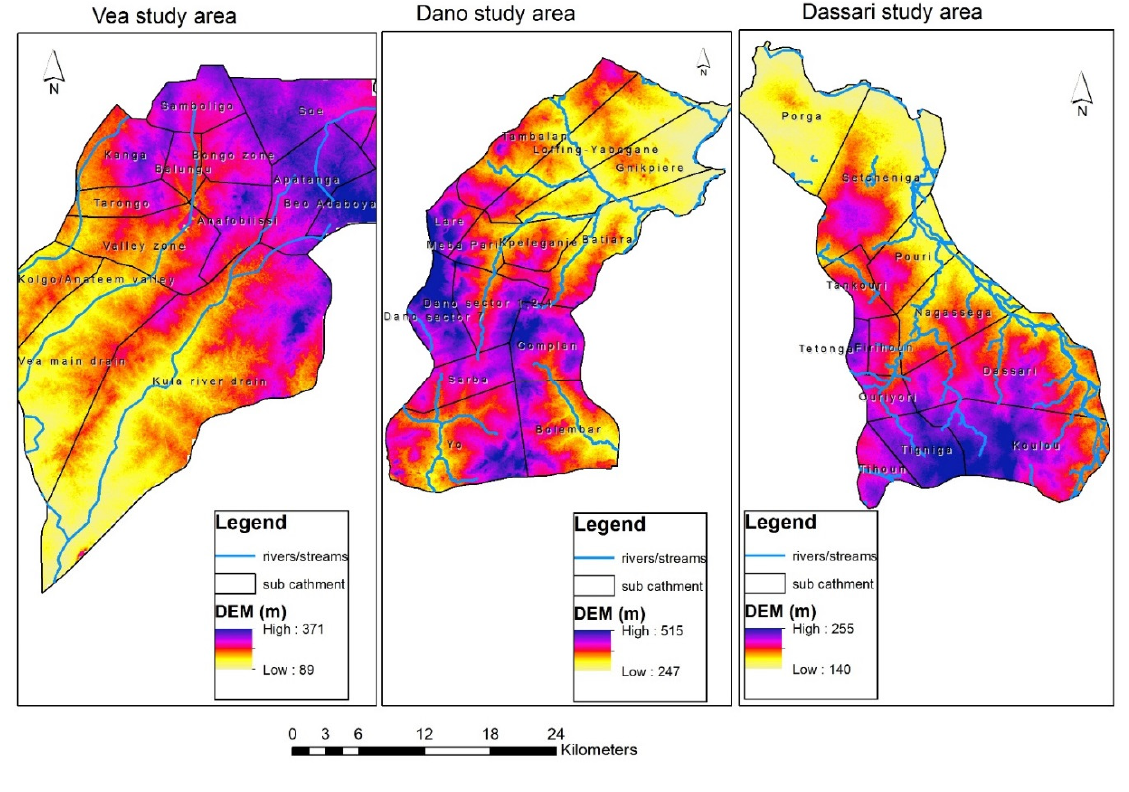
Figure 7. Digital Elevation Model (DEM) of the study